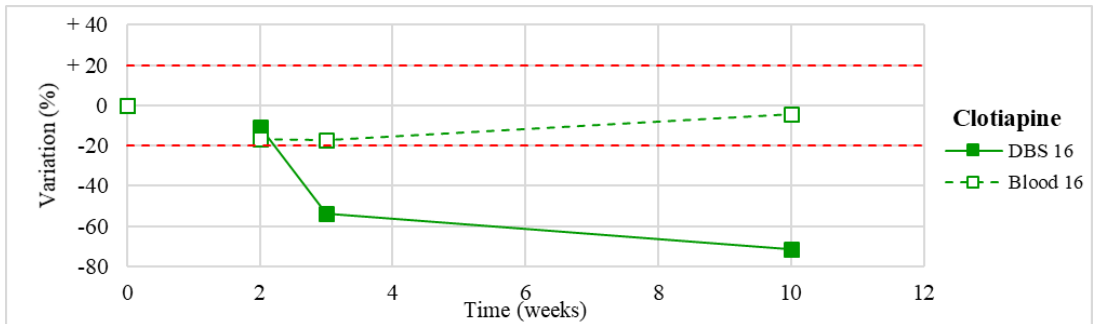
Figure 18. Long-term stability of paliperidone ( n = 1) in DBSs stored at room temperature and in blood stored at −20 °C.